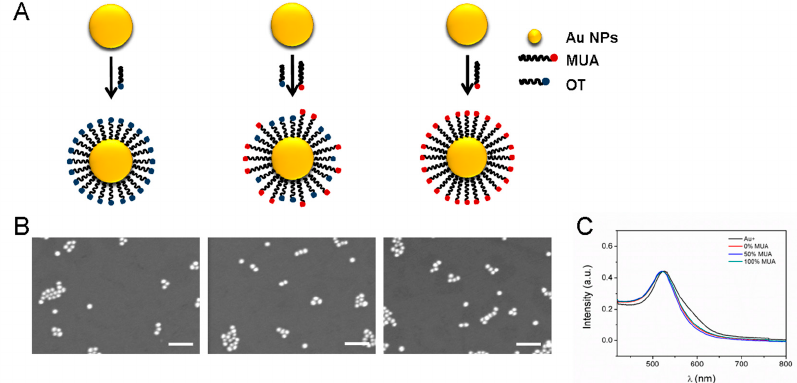
Figure 1. Characterization of gold nanoparticles (GNPs) with di ff erent surface modifications. ( A ) Schematic of GNP surface modifications with 0% MUA, 50% MUA, and 100% MUA. ( B ) SEM images of di ff erent surface-modified GNPs. Scale bar is 100 µ m. ( C ) Ultraviolet-visible spectra of GNPs before and after surface